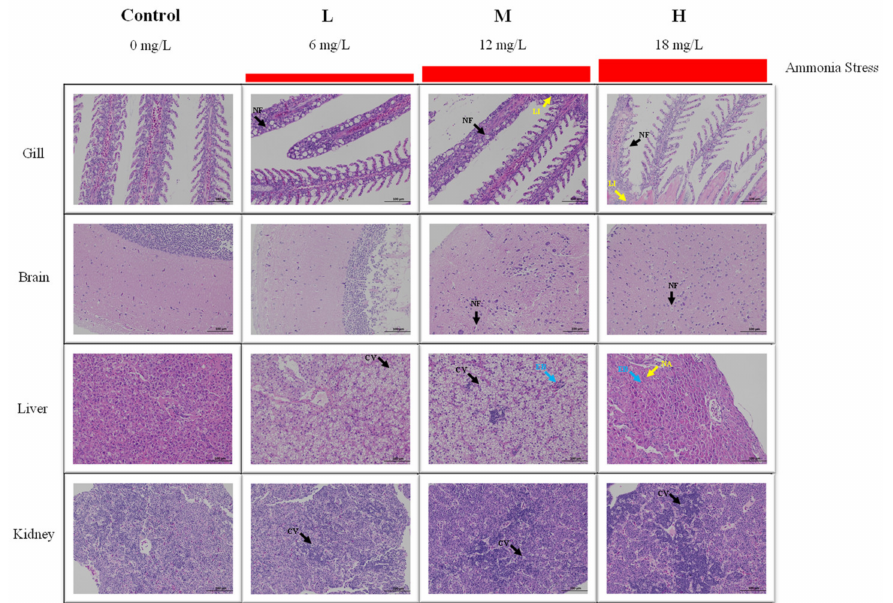
Figure 2. Effect of ammonia stress on histology of juvenile M. salmoides at 96 h. NF: nuclear frag- mentation; LI: lymphocyte infiltration; CV: cytoplasmic vacuolization; EB: eosinophilic bodies; NA: nucleolar